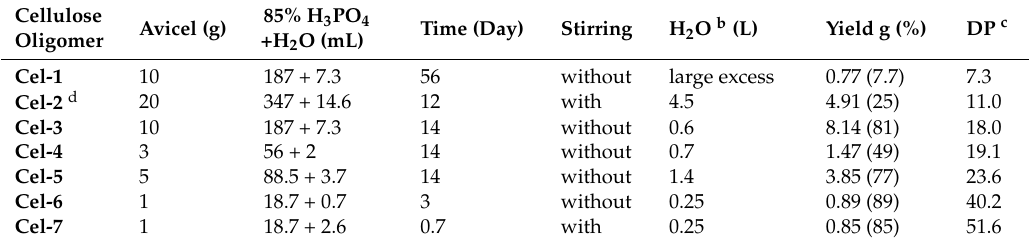
Table 1. Preparation of cellulose oligomers with lower DPs using Avicel a .